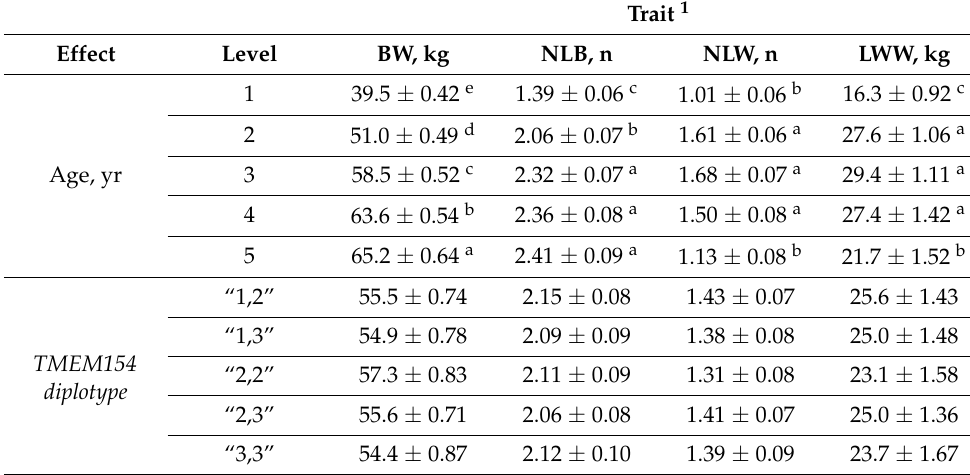
Table 2. Least-squares means ( ± SE) for the main effects of ewe age and TMEM154 diplotype on annual body weight at breeding and reproductive performance in Experimental flock 2.